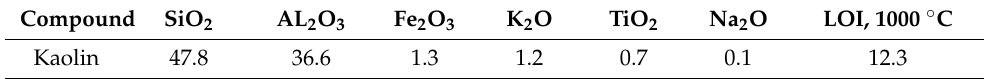
Figure 3. SEM micrographs presenting the microstructure of the used raw materials at 5000 × magnification: ( a ) MK; ( b ) Zeolite 4A. Table 1. Chemical composition of solid raw materials shown as weight percentage